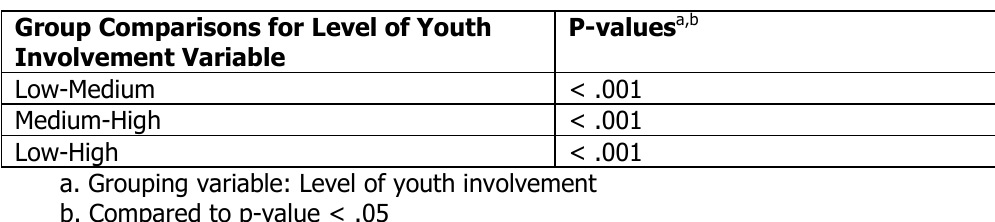
Mann-Whitney U 2-sample tests to compare organizations with low, medium, and high levels of youth involvement, Alachua County, Florida,